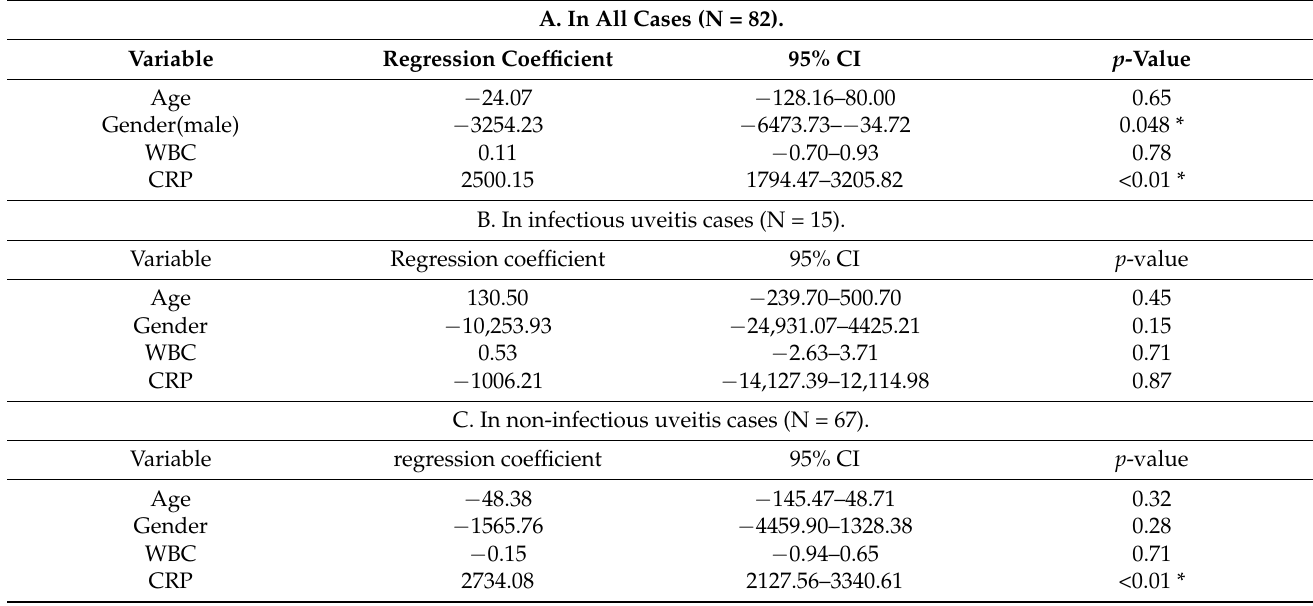
Table 2. Multivariate regression analysis: correlations between IL-6, age, gender, WBC and CRP. A. In All Cases (N =